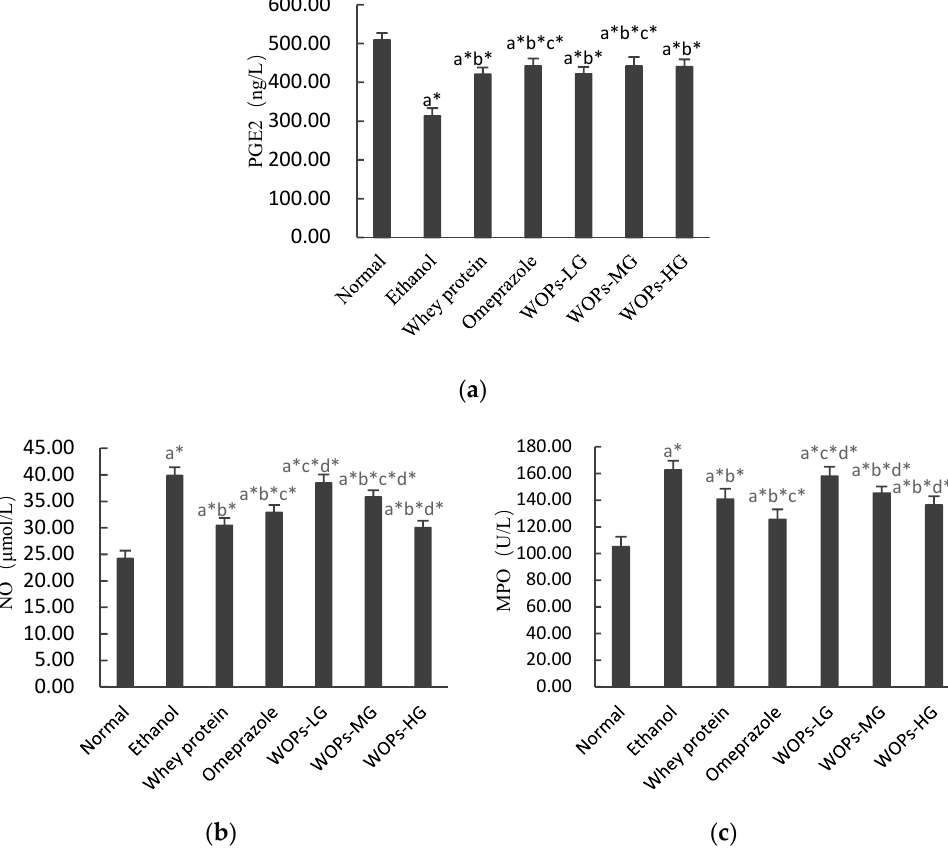
Figure 2. Effects of WOPs on gastric PGE2 ( a ), NO ( b ), and MPO ( c ) levels in ethanol-induced rats. Values were expressed as mean ± SD ( n = 10); a, b, c, d means compared with normal group, ethanol group, whey protein group, and omeprazole group separately; * p < 0.05 was considered to have statistical differences. PGE2, prostaglandin E2; NO, nitric oxide; MPO, myeloperoxidase. WOPs-LG, 220 mg/kg of walnut oligopeptides group; WOPs-MG, 440 mg/kg of walnut oligopeptides group; WOPs-HG, 880 mg/kg of walnut oligopeptides group.